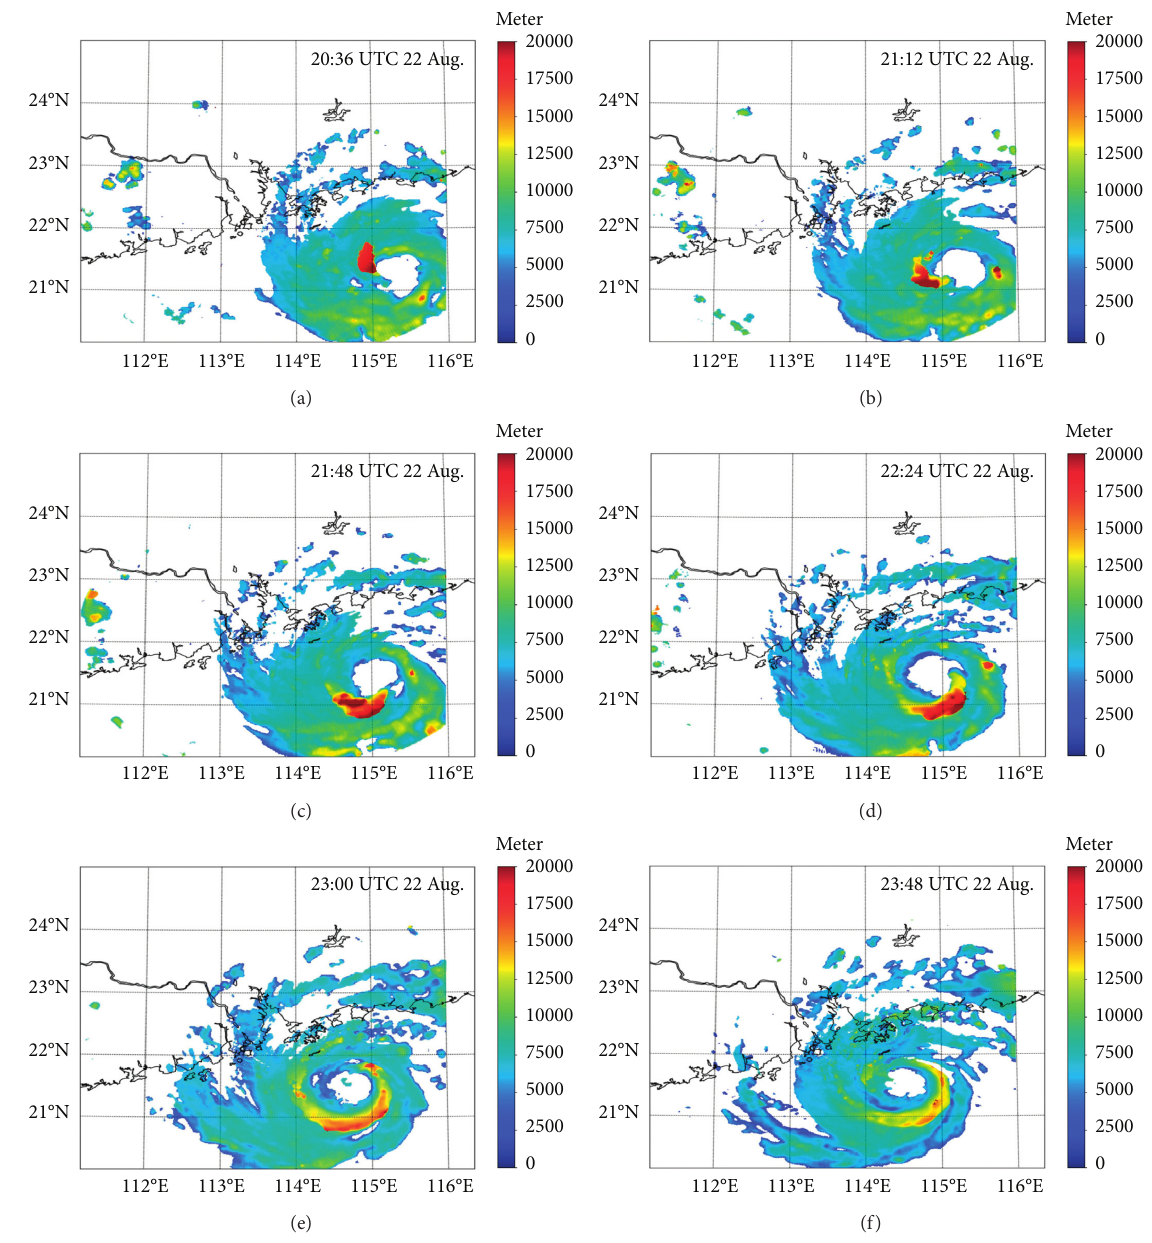
Figure 2: Peak height of radar composite reflectivity at 18dBZ from a concatenation of radar echo images from Zhuhai and Hong Kong of the CMA on 22 August 2017: (a) 20:36 UTC, (b) 21:12 UTC, (c) 21:48 UTC, (d) 22:24 UTC, (e) 23:00 UTC, and (f) 23:48